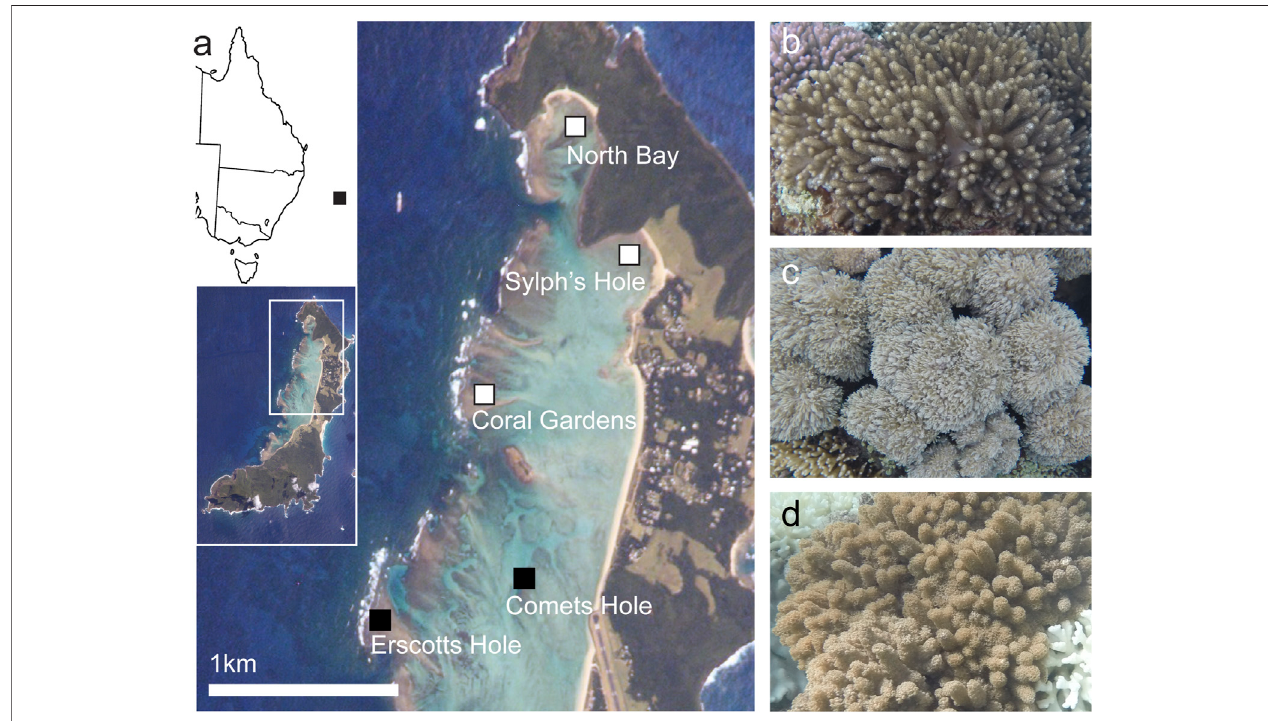
FIGURE 1 | Study sites and species. (A) Closeup map of Lord Howe Island, with map of the east coast of Australia and full island map inset. Sites where both surveys and collection were conducted – North Bay, Sylphs Hole, and Coral Gardens – are marked in white with black border, sites where only surveys were conducted – Comets Hole and Erscotts Hole – are marked in black. Lord Howe Island image courtesy of the Image Science and Analysis Laboratory, NASA Johnson Space Center; line map of Australia modi fi ed from “ Australia states blank. png ” by Golbez on Wikimedia Commons. (B) Cladiella sp. 1, (C) Xenia cf crassa , (D) Cladiella sp. 2. All coral photos by Rosemary K.